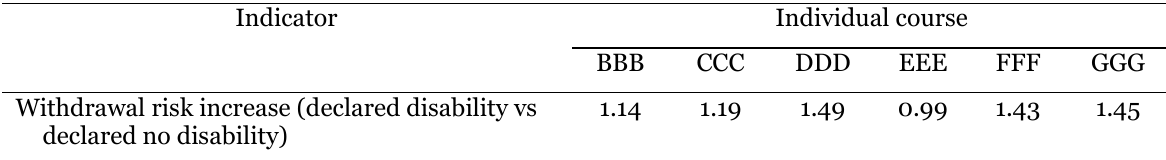
Impact of Disability on Withdrawal Risk—Individual Course